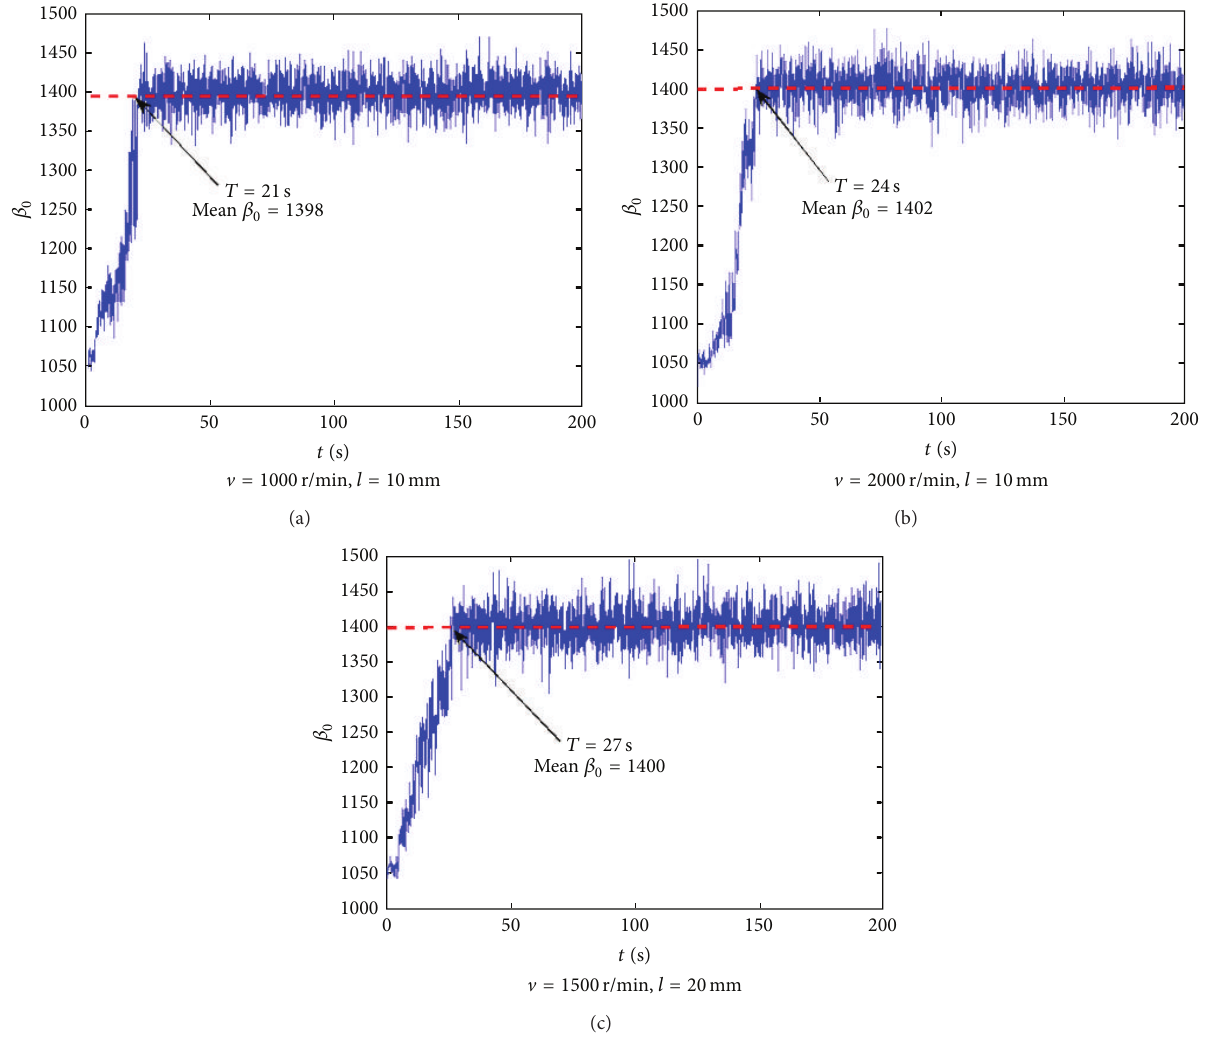
Figure 5: Evolution curves of 0-dimensional Betti